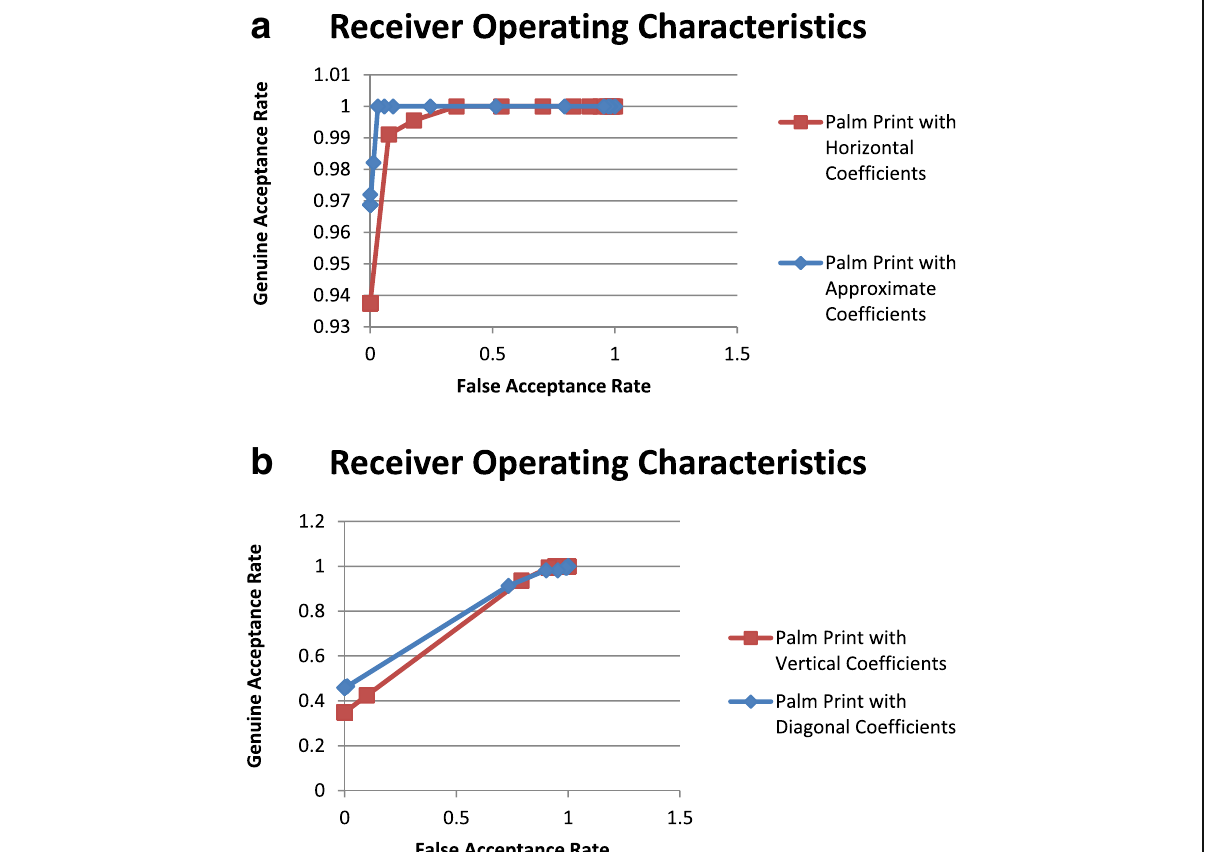
Fig. 7 a ROC curves plotted using approximate and horizontal wavelet coefficients for PP modality. b ROC curves plotted using vertical and diagonal wavelet coefficients for PP modality